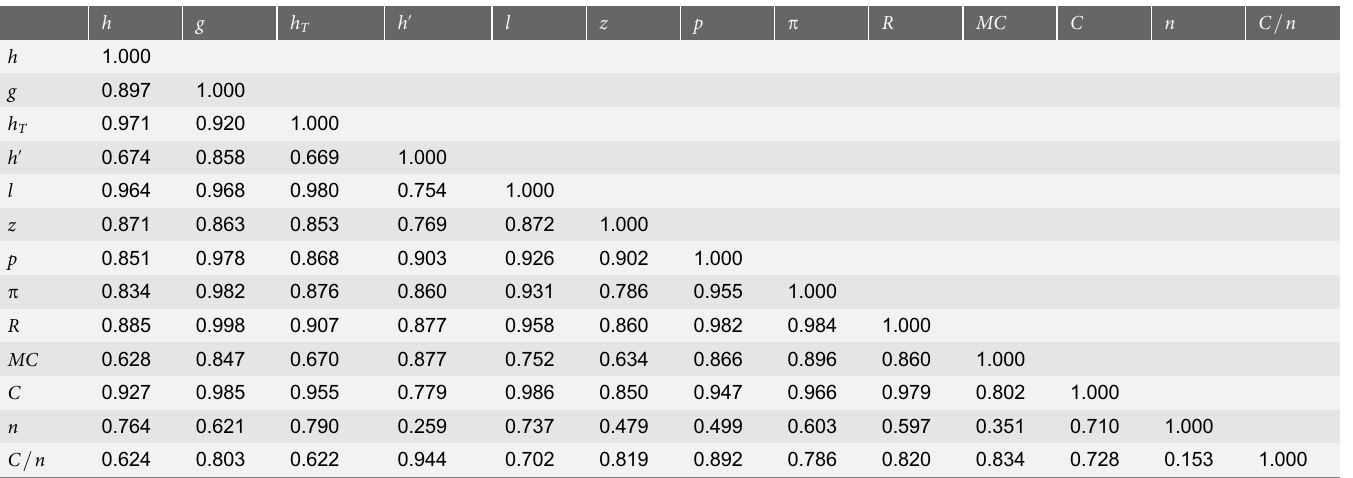
Table 3. Spearman correlation coefficients.